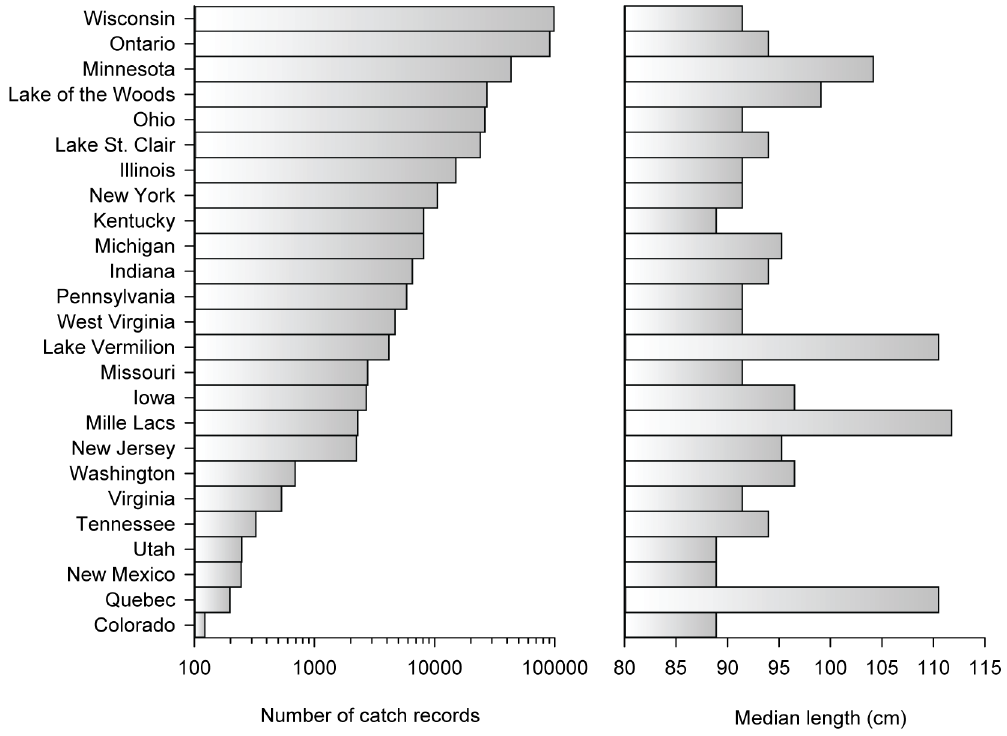
Figure 1. Number of catch records and median fish length by state, province, and water body. Groups with , 100 fish are not shown.